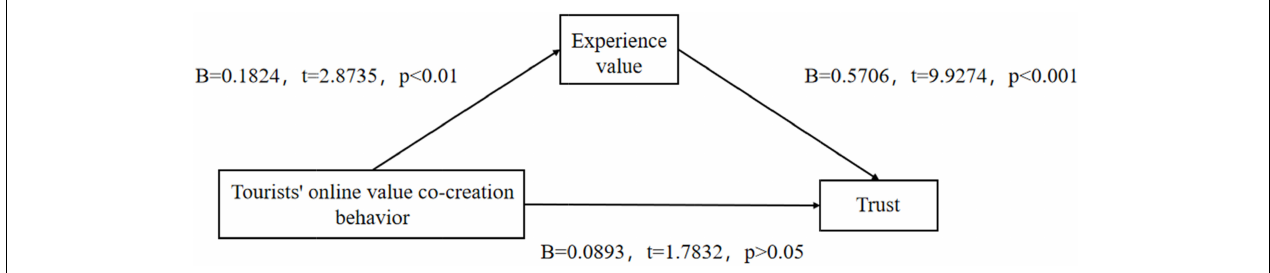
FIGURE 2 | Test of mediating effect of experiential